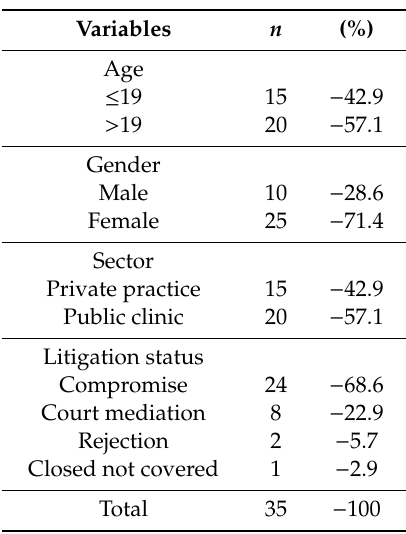
Table 1. Data of compensated